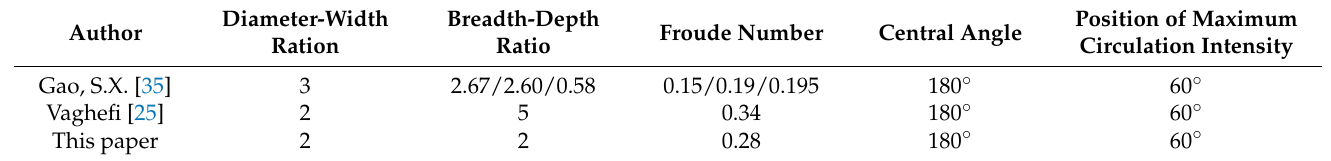
Table 3. Locations of the maximum circulation strength corresponding to different parameters.